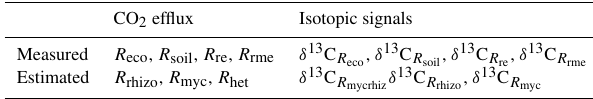
Table 1. Measured and estimated CO 2 effluxes and isotopic signals in this study. CO 2 efflux Isotopic